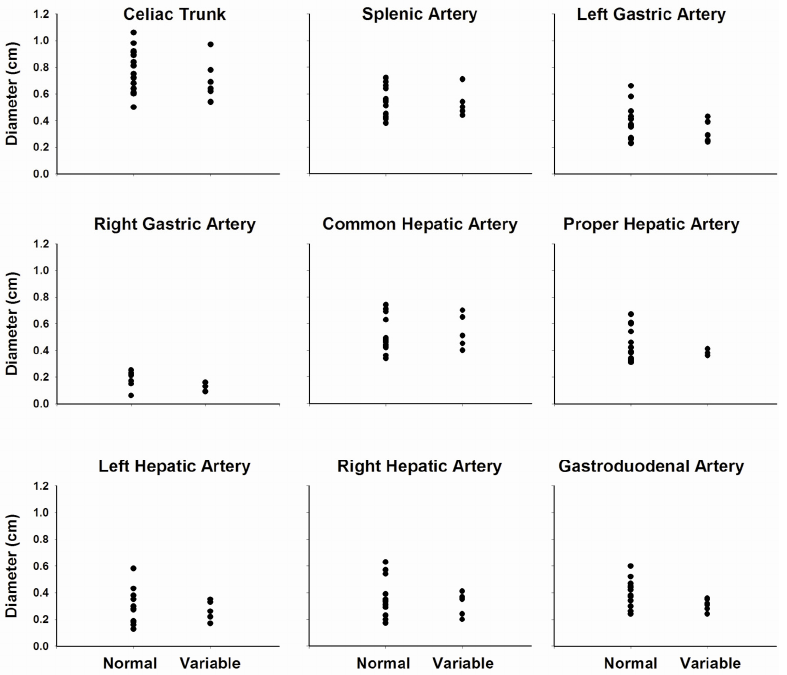
FIGURE 1 - Scatter plot graphs showing individual arterial diameter values of the celiac trunk, splenic artery, left and right gastric arteries, common hepatic artery, proper hepatic artery, left and right hepatic arteries and gastroduodenal artery, in normal and variable individuals. Note that the variable arteries usually showed smaller arterial diameter values than the normal arteries. Also, normal arteries showed a wider range of diameters compared to variable arteries. No significant differences were observed between groups for any of the arteries